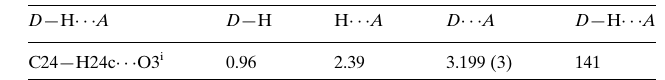
Hydrogen-bond geometry (A˚ , (cid:3)